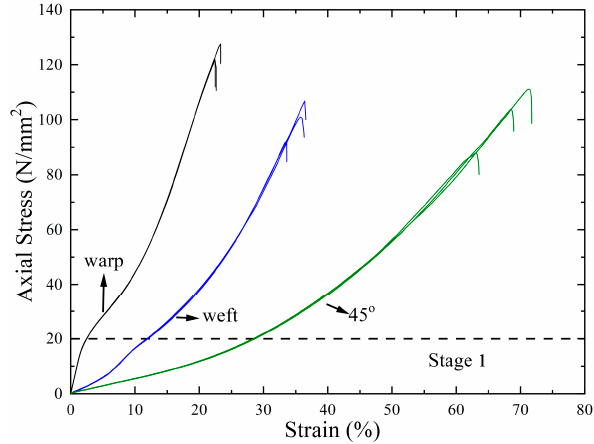
Figure 12. Stress–strain curves for fabric membrane strap.